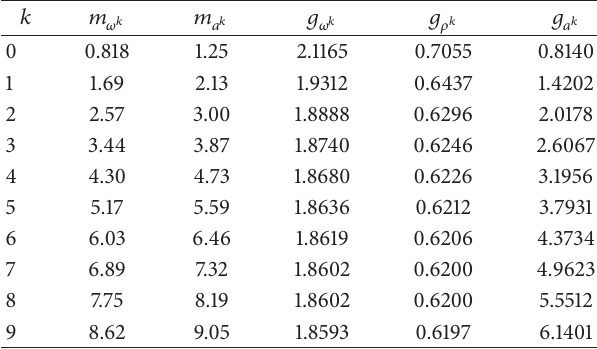
Table 4: The values of meson-nucleon couplings and mass of mesons in the SS model. The values of 𝑁 𝑐 = 3 , 𝜆 = 400 , and = 550 MeV are supposed in calculations. 𝑚 𝑁